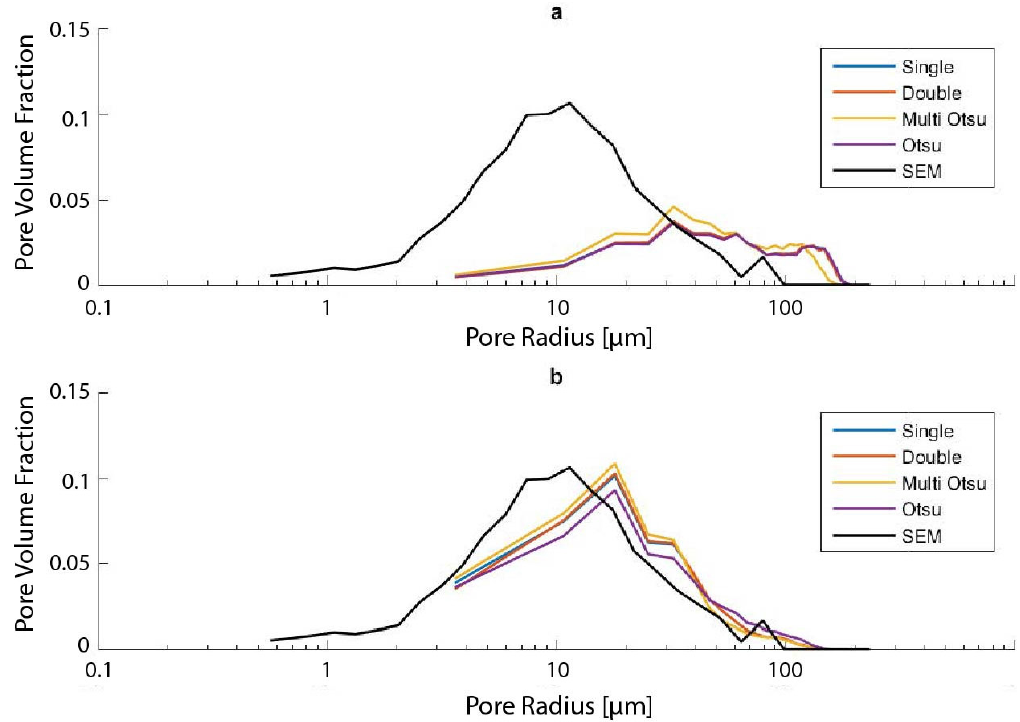
Figure 11. Comparison of SEM and CT-derived pore-size distributions for grainstone shoal sample 403 as a function of processing. ( a ) Di ff usion processing ( b ) Ring processing.